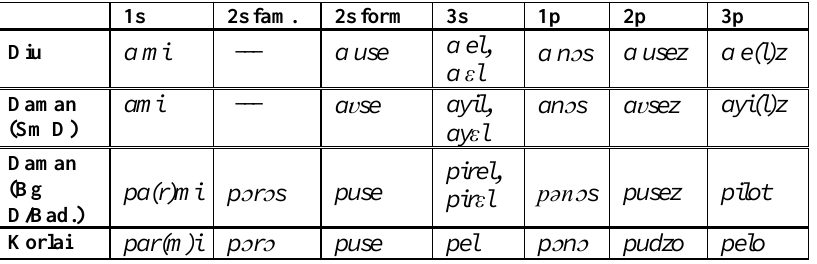
Table XI. Object pronominal systems in Diu, Daman, and Korlai (Cardoso, 2009: 131- -132 for Diu, Clements & Koontz-Garboden 2002: 207-209 for Daman and